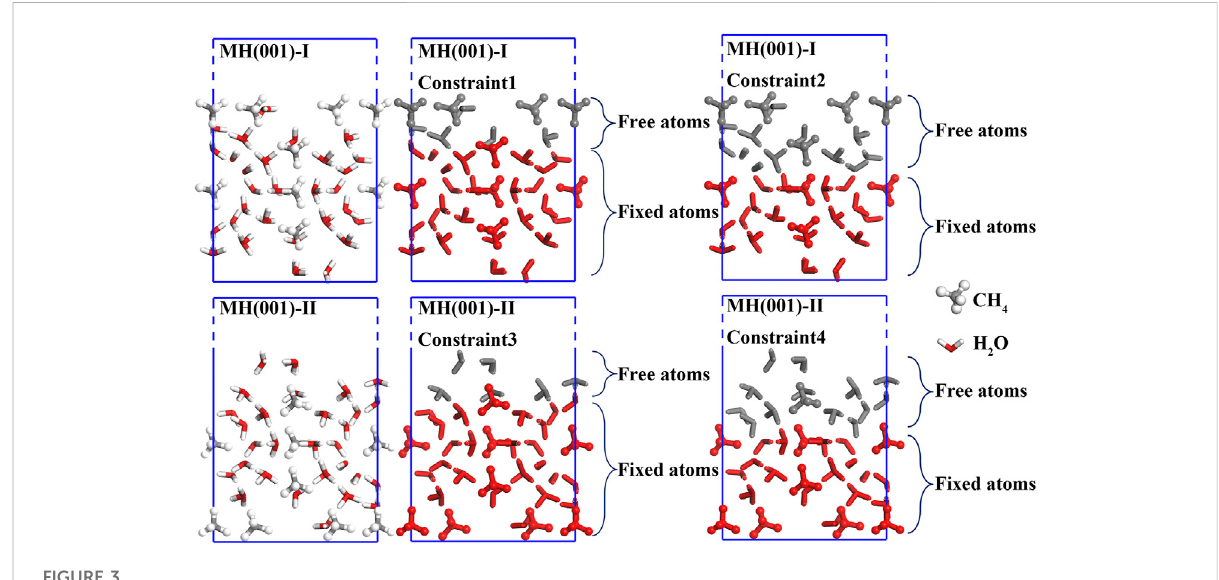
TABLE 4 Calculated energy differences ( Δ E ) between initial and optimized surface models of sI-MH. Surface